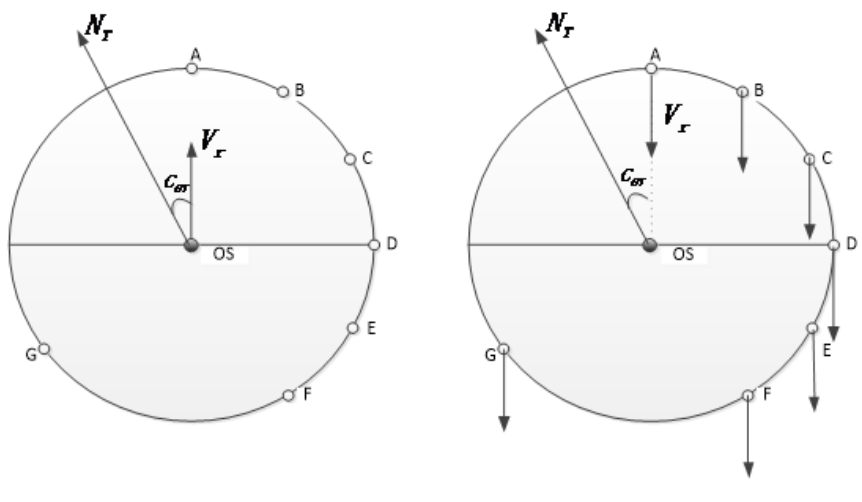
Figure 2. Relative motion between own ship and target ship .